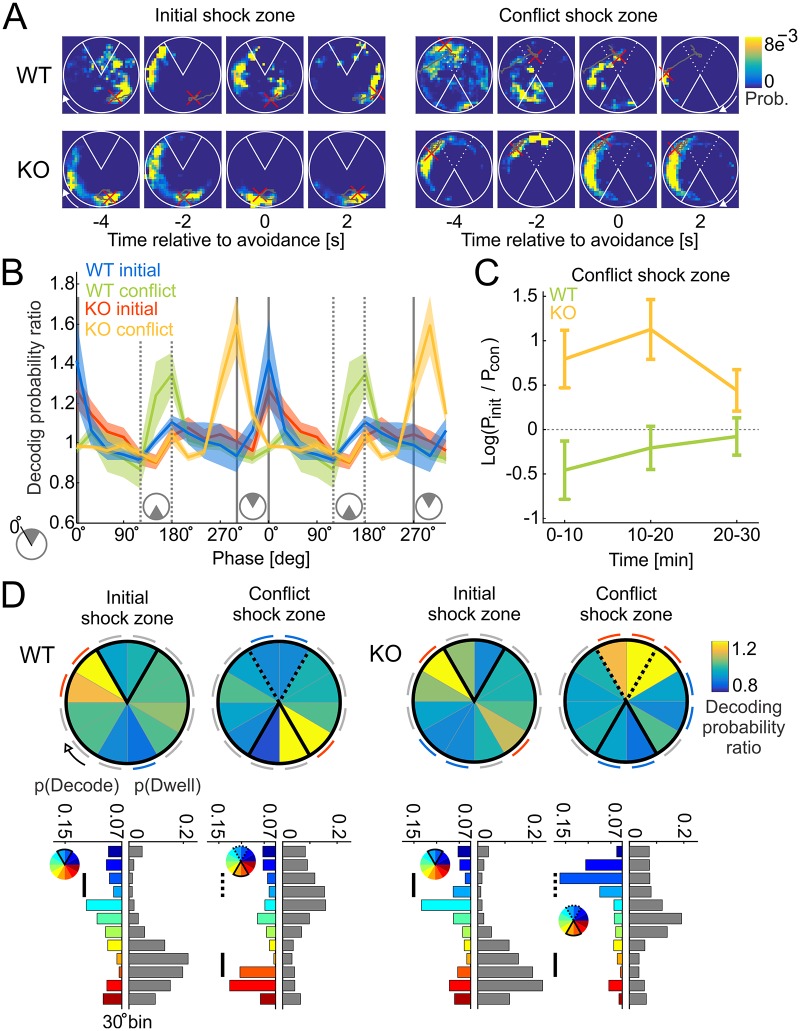
During SGdom events, putative pyramidal cell ensemble discharge represents the vicinity of shock.(A) Four examples of the time evolution of the Bayesian posterior probability from before to after avoiding the shock zone (white sector centered at 12 o’clock for the initial shock zone and 6 o’clock for the conflict shock zone). The mouse’s path during the episode is shown in gray, with the current location indicated by a red cross. The top row corresponds to a WT mouse, the bottom row to a Fmr1-KO mouse. The left examples illustrate training to the initial shock zone. The right examples are after the shock was relocated for conflict training. The initial shock zone location in conflict training is shown as a dotted line. (B) Average normalized posterior probability as a distance from the leading edge of the shock zone. Full gray lines mark the location of the initial shock zone; dotted lines mark the location of the conflict shock zone. Data are represented as averages ± SEM. (C) Ratio of average posterior probability at the location of the initial shock zone and the location of the conflict shock zone in 10-min intervals. (D) Top: summary of normalized posterior probability estimates obtained during SGdom events for the initial and conflict shock zone sessions for WT (left) and Fmr1-KO (right) mice. Notice maximal decoding probability at the leading edge of the shock zone in both WT and KO mice during the initial shock zone session, and during the conflict session, maximal decoding probability is at the leading edge of the relocated shock zone in WT mice but not in Fmr1-KO mice. During conflict, Fmr1-KO ensemble discharge decodes to the vicinity of the initial shock zone that is currently incorrect for avoiding shock. Red arcs located next to angular bins indicate significantly positive (>1) normalized probability (p < 0.05), blue arcs indicate significantly negative (<1) normalized probability (p < 0.05), gray arcs indicate n.s. relative to 1. Bottom: split bar plots comparing the decoding probability distributions (color: each color corresponds to one 30° angular position) and dwell distributions (gray) for corresponding trials. Black vertical lines mark regions inside of the currently correct shock zone. Dotted vertical lines in conflict trials mark regions inside the initially correct shock zone. KO, knockout; n.s., not significant; Pint, probability at the initial shock zone location; Pcon, probability at the conflict shock zone location; SG, slow gamma; WT, wild-type. Underlying data can be found here: [https://goo.gl/oHH22A].